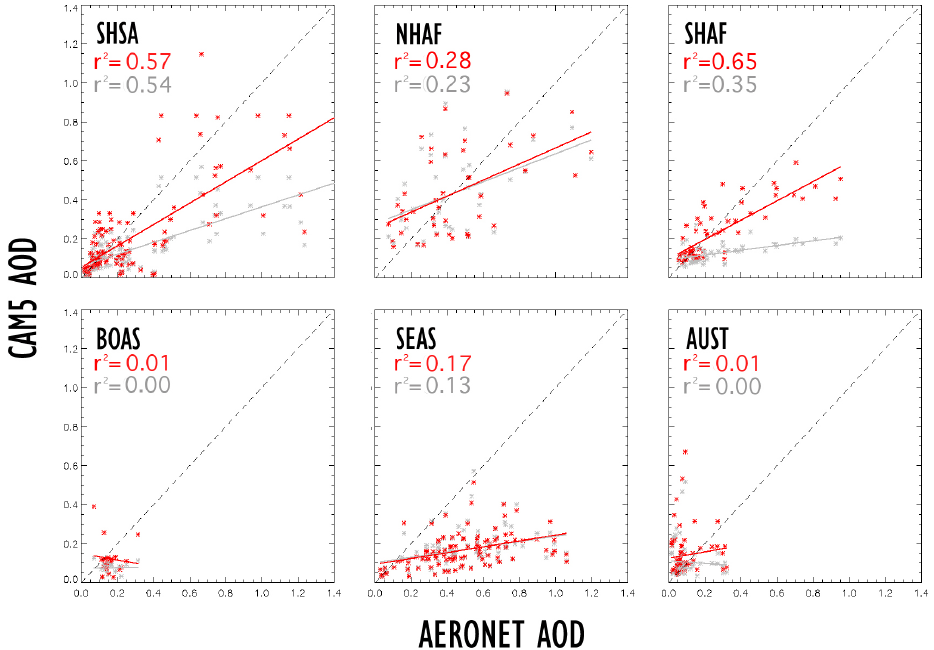
Fig. A1. Scatterplots of the monthly mean model AOD vs. AERONET AOD for different GFED regions and the globe with linear regression lines plotted. Results from simulations with both the un-scaled GFEDv2 emissions (gray) and scaled emissions (red) are shown. The region abbreviations are Southern Hemisphere South America (SHSA), Northern Hemisphere Africa (NHAF), Southern Hemisphere Africa (SHAF), boreal Asia (BOAS), southeastern Asia (SEAS), and Australia (AUST). Equatorial Asia (EQAS) is excluded due to the small number of AERONET data points within this region.